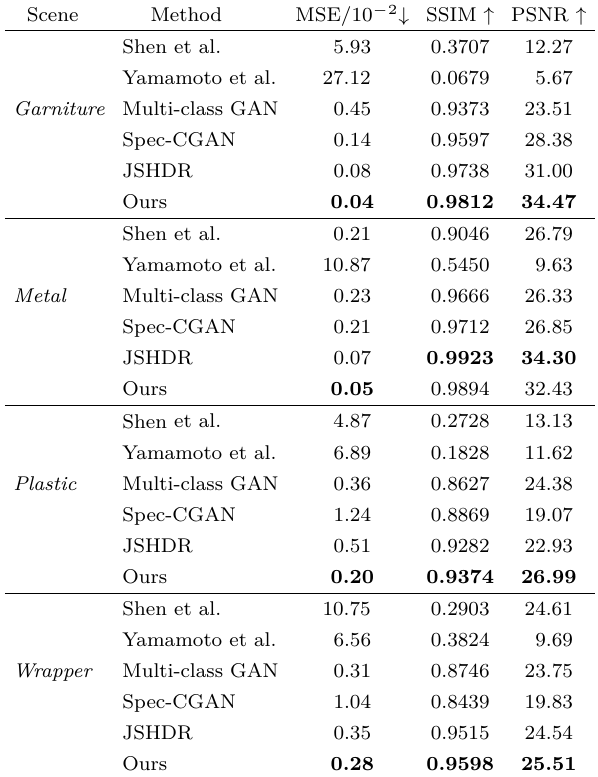
Table 2 Quantitative comparison of highlight removal methods on the SHIQ